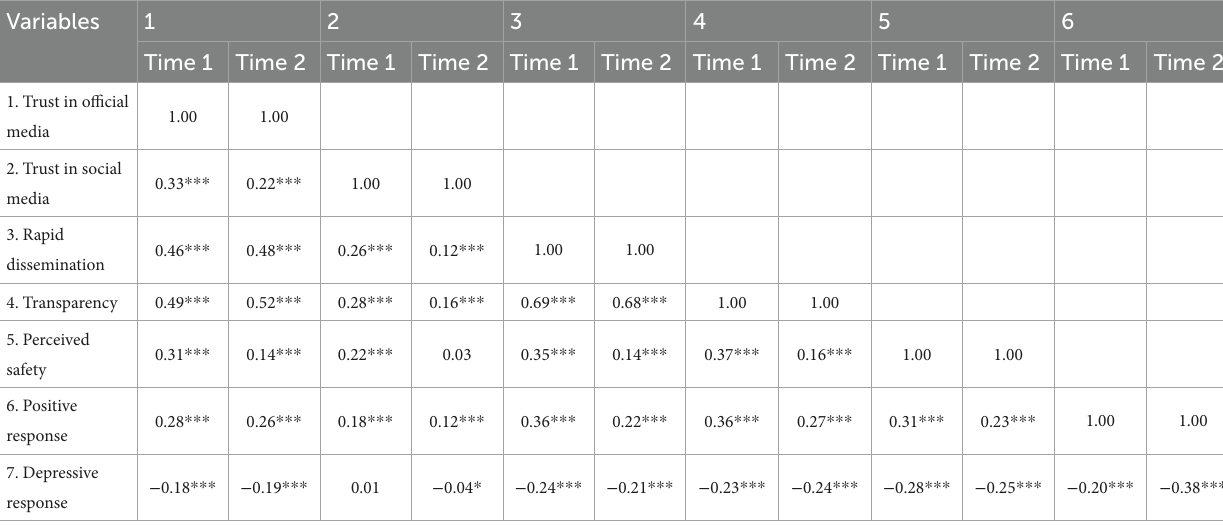
TABLE 3 Pearson correlations between the measured variables at Time 1 and Time 2.